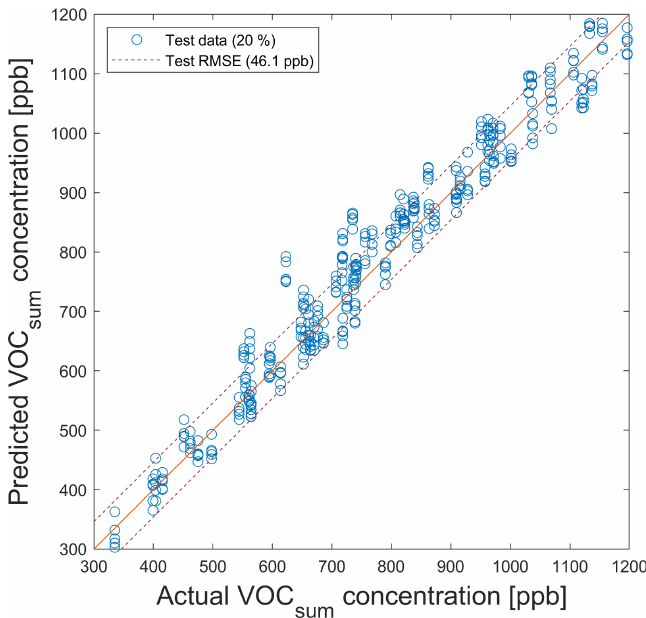
Figure A4. PLSR model for the quantification of VOC sum for testing with test data from the data split shown in Fig. 5. Dashed lines indicate the RMSE of test data (T −